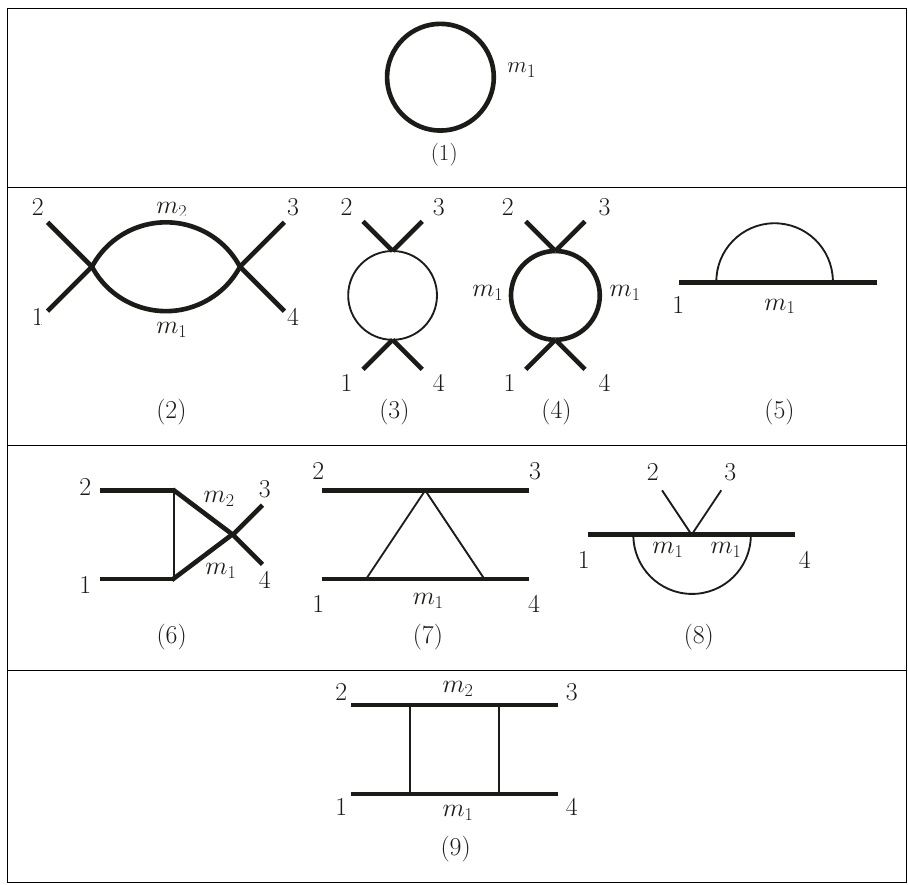
Table 3 . Master integrals I (1)